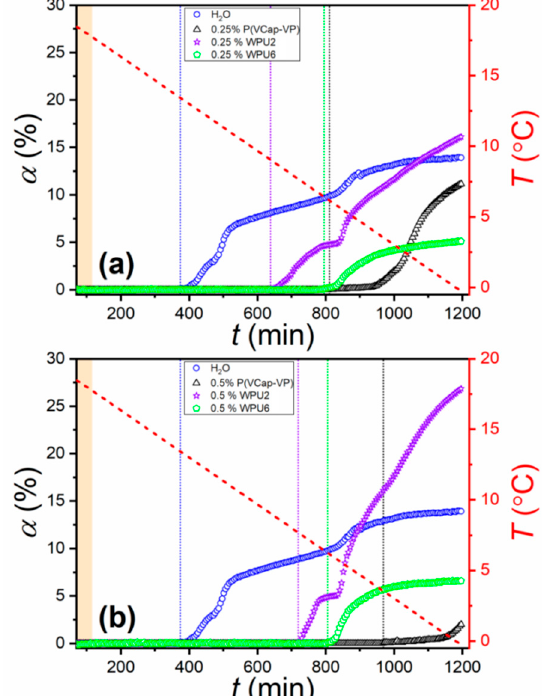
Figure 2. The gas consumption in the absence and presence of polyurethanes and P(VCap-VP) at concentrations of 0.25 wt% ( a ) and 0.5 wt% ( b ); color-filled areas correspond to P , T -conditions outside the thermodynamic stability of gas hydrate, white area matches hydrate stability zone; red dashed lines are temperature plots; markers are mean values of relative pressure decrease for each sample; vertical color dashed lines show moment when a mean value for each sample becomes more than 0.07%.